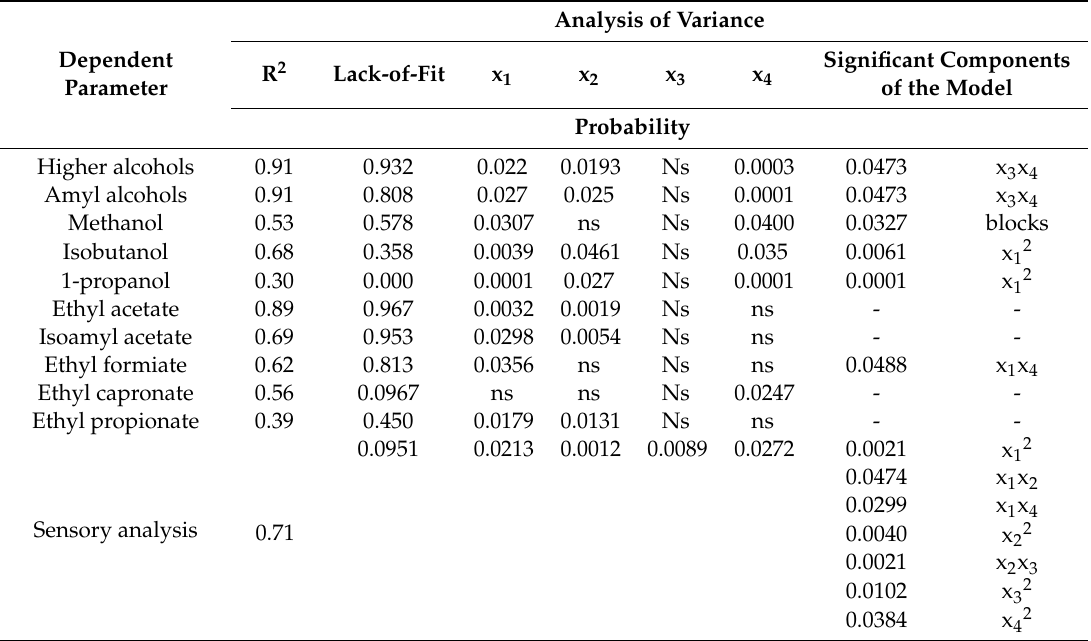
Table 2. Analysis of variance of volatile esters and fusel alcohols: Significance of model components and assessment of adequacy of the models.